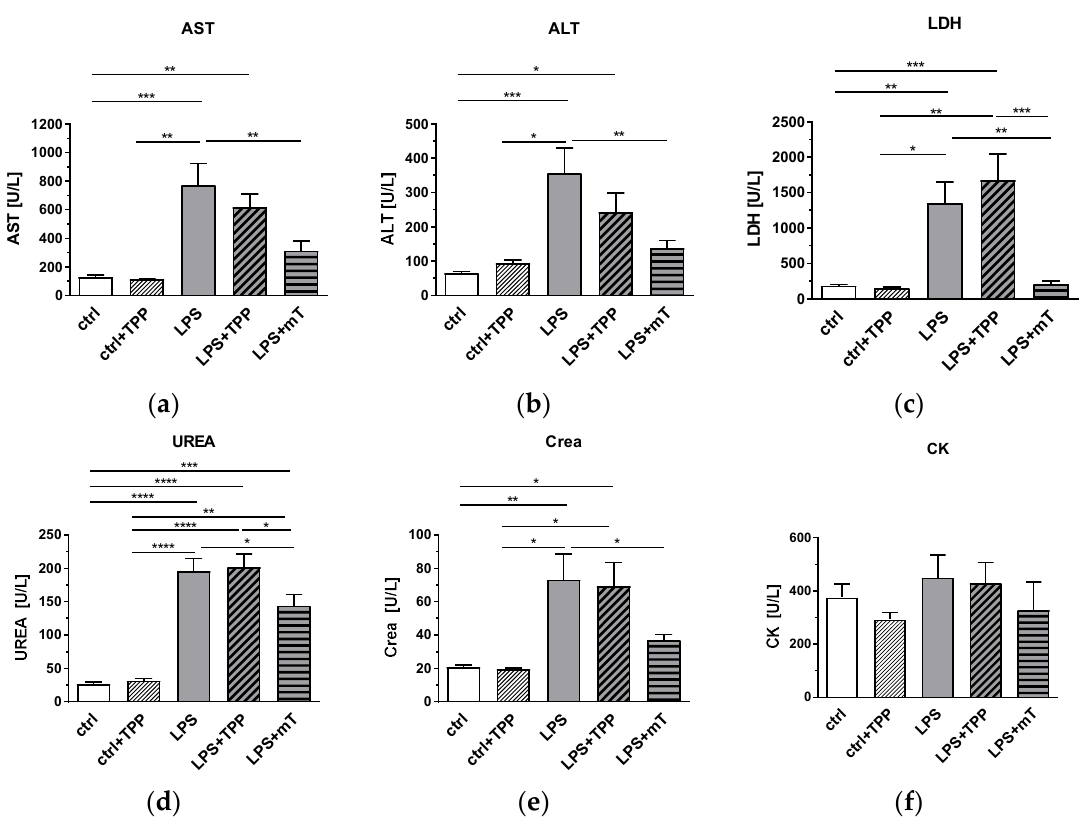
Figure 4. Effect of lipopolysaccharide (LPS, 1.75 mg/kg), methyltriphenylphosphonium chloride (TPP, 50 nmol/kg) and mitoTEMPO (mT, 50 nmol/kg) on organ damage markers. An increase for few values is seen in the LPS + TPP group compared to the LPS group for all tissue damage markers. LDH showed significant difference between the LPS + TPP and all other groups. The LPS + mitoTEMPO seems to indicate beneficial effects of antioxidants (AOX) being lower than both the LPS and the LPS + TPP groups for all values measured; ( a ) aspartate aminotransferase (AST), ( b ) alanine aminotransferase (ALT), ( c ) lactate dehydrogenase (LDH), ( d ) urea, ( e ) creatinine (Crea) and ( f ) creatine kinase (CK). One-way analysis of variance (ANOVA), Fisher’s least significant difference (LSD), n = 3–8, mean ± SEM, * p < 0.05, ** p < 0.01, *** p < 0.001, **** p <